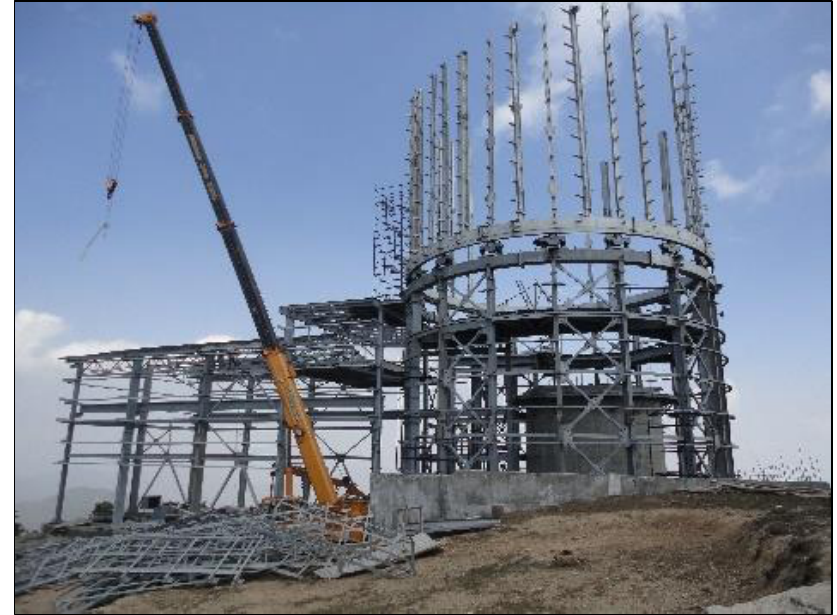
Figure 9. Erection of enclosure components using mobile